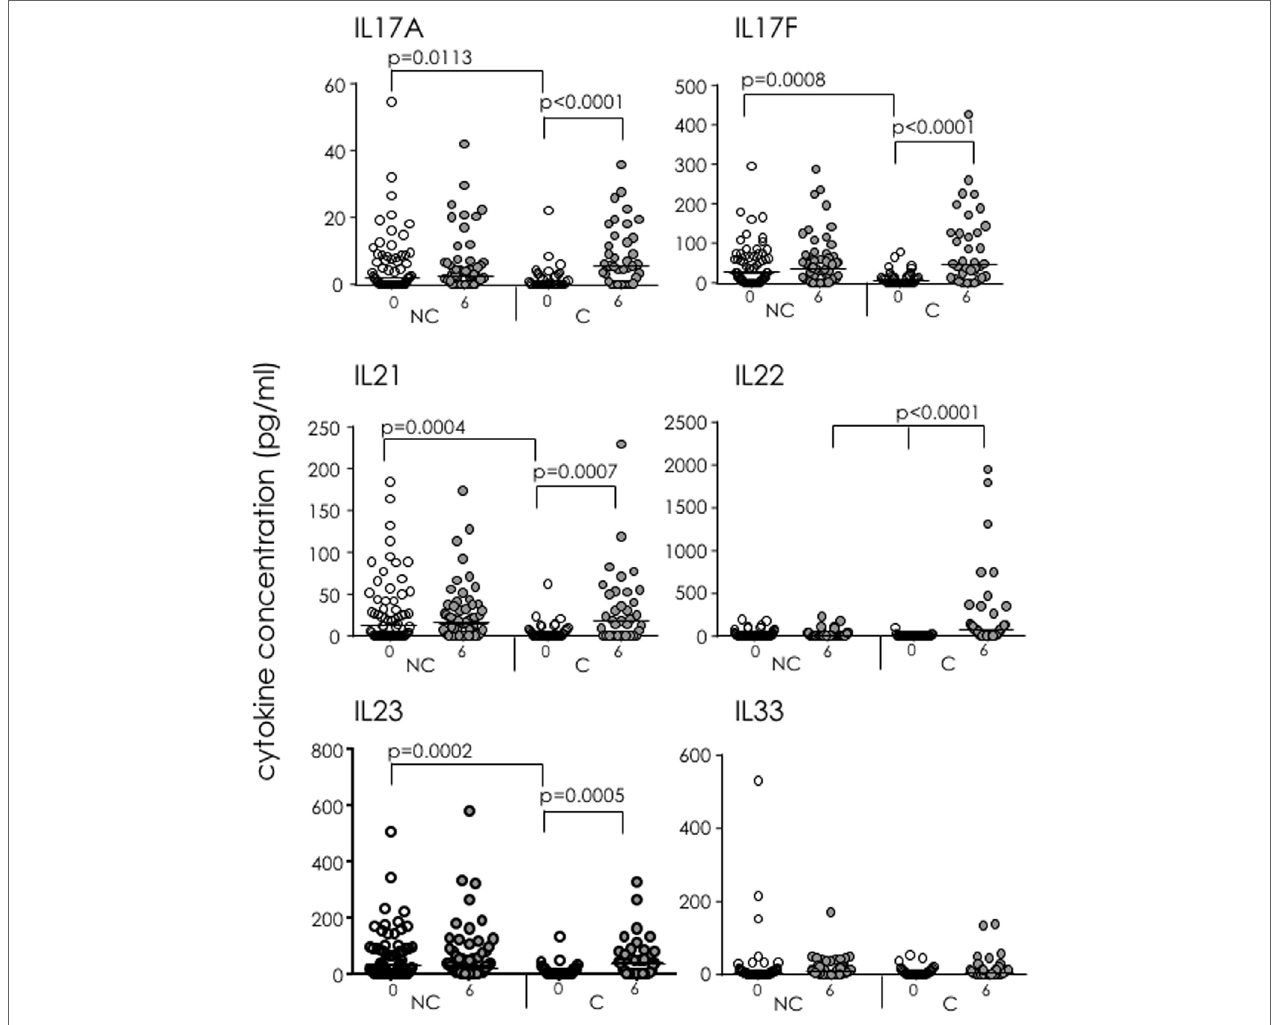
FigUre 6 | Soluble IL-17 superfamily factors in IFN- γ -release assay (IGRA) converters (C) and non-converters (NC) following ESAT-6/CFP-10 stimulation of whole blood. 15-plex Th17 cytokine profiles were analyzed following EC stimulation of whole blood from IGRA NC and C at recruitment (white dots) and 6 months (gray dots). Showing IL-17A, IL-17F, IL-21, IL-22, IL-23, and IL-33. Data were analyzed using Kruskal–Wallis test followed by Dunn’s post-test comparison. Bar indicates